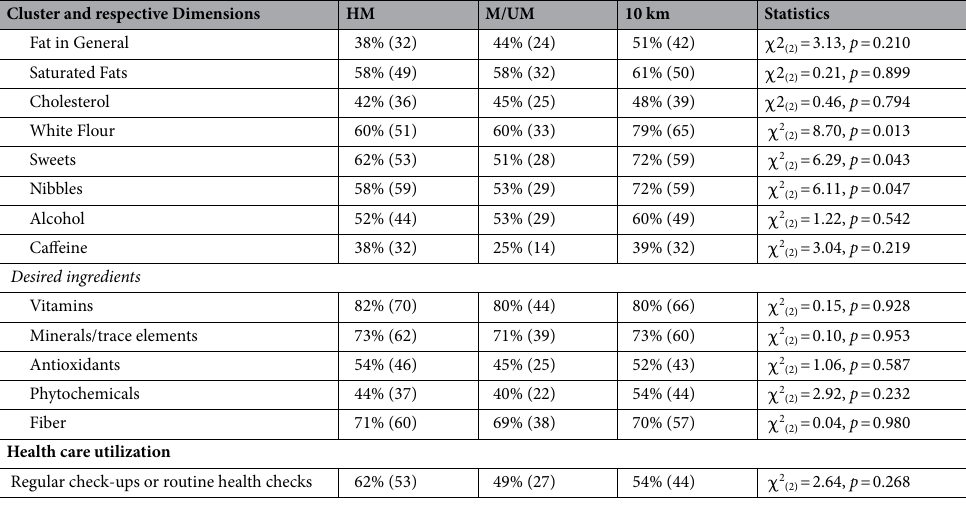
Table 3. Descriptive and ANOVA results for the eight dimensions of health status displayed by race distance. Data are presented as “percentage of prevalence (n)” or “median (IQR)”. BMI body mass index, BW body weight, HM half-marathon, IQR interquartile range, km kilometers, M/UM marathon/ultra-marathon.